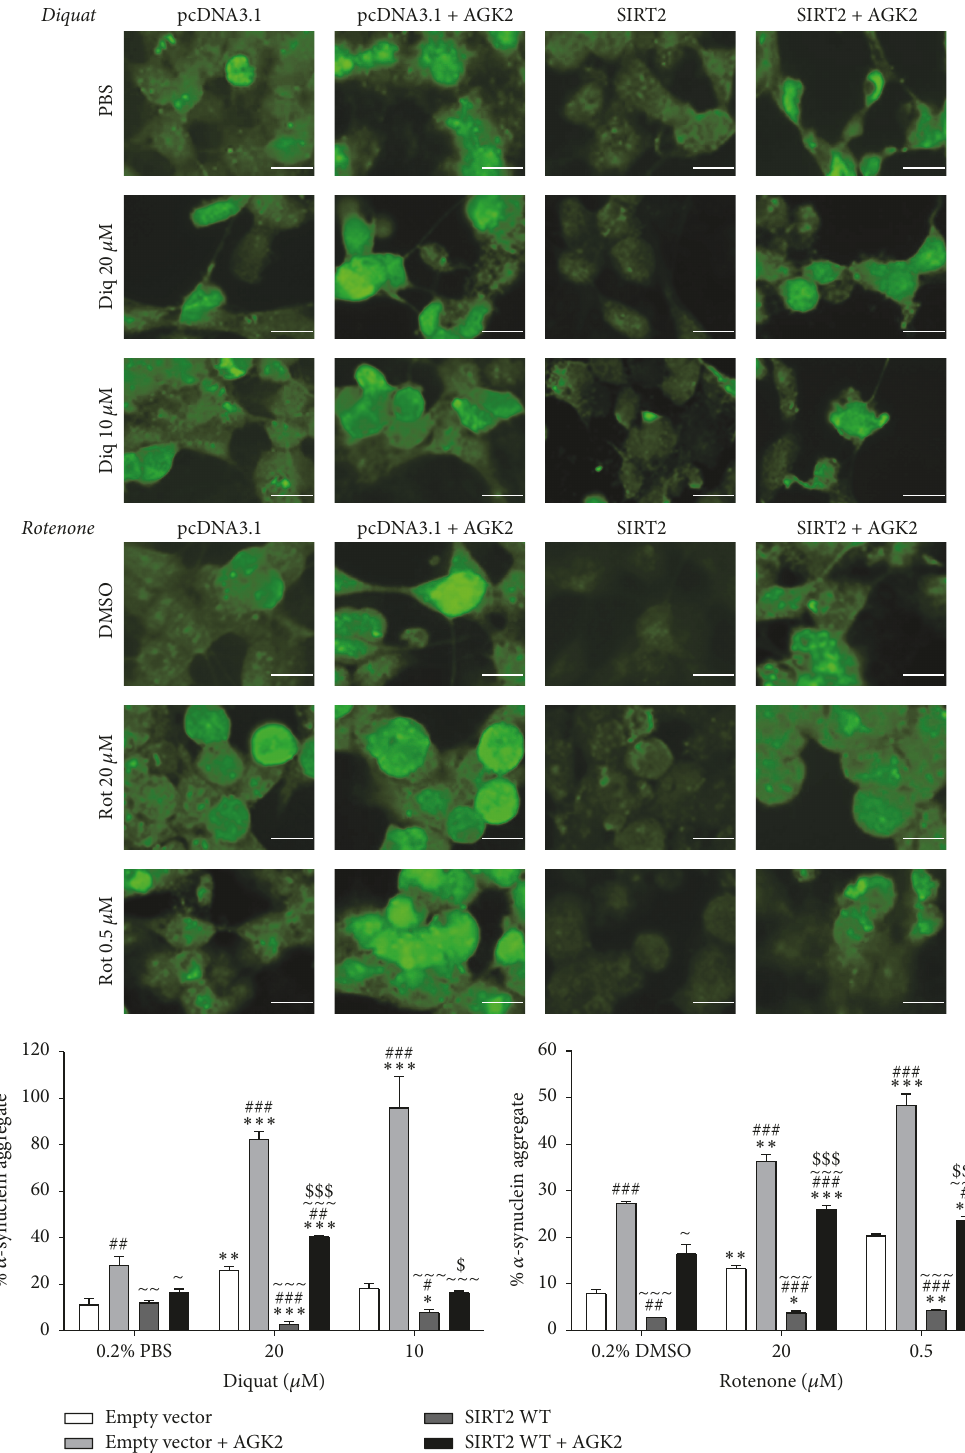
Figure 5: 𝛼 -Synuclein aggregate formation and quantification in toxin treated SH-SY5Y cells. SIRT2 overexpressing SH-SY5Y cells were treated with toxin (20 𝜇 M or 10 𝜇 M diquat or 20 𝜇 M or 0.5 𝜇 M rotenone) and 0.2% PBS or DMSO; cells transfected with empty vector were used as a control and another set of SIRT2 and control cells was coincubated with AGK2 and toxin. Cells were immunostained with phospho- 𝛼 -synuclein. Images were captured through GFP filter under 63x magnification. The captured images represent 𝛼 -synuclein staining and the bar graphs represent the aggregate quantification in diquat or rotenone treated cells. Each bar represents % 𝛼 -synuclein aggregates ( ± SD) from three independent assays ( 𝑛 = 3 ). ∗∗∗ 𝑝 < 0.001 , ∗∗ 𝑝 < 0.01 , and ∗ 𝑝 < 0.05 when compared to 0.2% vehicle, one-way ANOVA (Bonferroni corrected), ### 𝑝 < 0.001 , ## 𝑝 < 0.01 , and # 𝑝 < 0.05 when compared to control cells, ∼∼∼ 𝑝 < 0.001 , ∼∼ 𝑝 < 0.01 , and ∼ 𝑝 < 0.05 when compared to control + AGK2 treatment, and $$$ 𝑝 < 0.001 and $ 𝑝 < 0.05 when compared to SIRT2 cells, two-way ANOVA (Bonferroni corrected). Scale bar: 20 𝜇